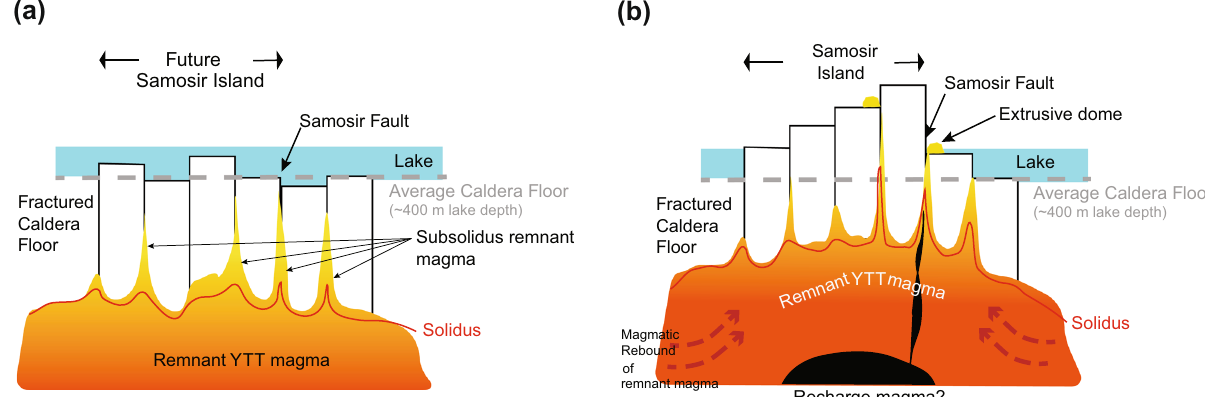
Fig. 5 Schematic (not to scale) illustrating the pre-eruptive con fi guration for the Samosir domes and their subsolidus extrusion in the context of resurgent uplift of Samosir. Sections are W to E, looking North through Samosir Island. The average caldera fl oor is used as datum to illustrate the uplift of Samosir; faulting of the caldera fl oor is a schematic representation of observations presented by Mucek et al. 25 and Solada et al. 22 ; caldera margins, pre- and post-dome lake sedimentation not shown. a At 74 − 70 ka, caldera-forming eruption arrests as foundering block experiences resistance from increasingly crystal-rich magma transitioning to mush. Uppermost rinds of the magma reservoir in eruption conduits and faults in the piecemeal caldera fl oor are chilled rapidly preserving glass as hyperbyssal shallow subvolcanic intrusions. Lake fi lls within 1,500 years of caldera collapse and lake sedimentation commences. b After 70 ka, as the caldera reaches magmastatic, lithostatic, and isostatic equilibrium, magmatic rebound, and addition of new magma drive uplift of the caldera fl oor opening previous weaknesses to start forming Samosir Island. Penetration of remnant and recharge magma motivates plugs of subsolidus magma to extrude along faults forming small domes on the edge of Samosir along the Samosir fault and on top of the uplift. Samosir domes are primarily subsolidus extrusions, but may contain selvages of remnant suprasolidus and recharge